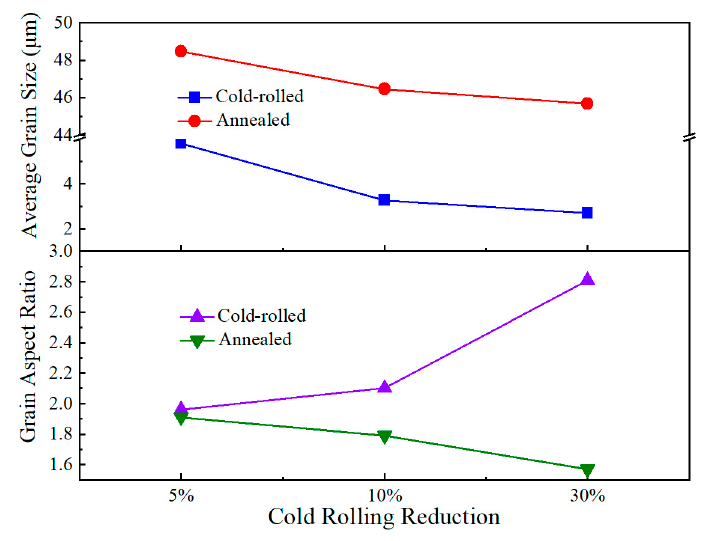
Figure 3. Average grain size and grain aspect ratio of the samples as a function of cold-rolling reduction.